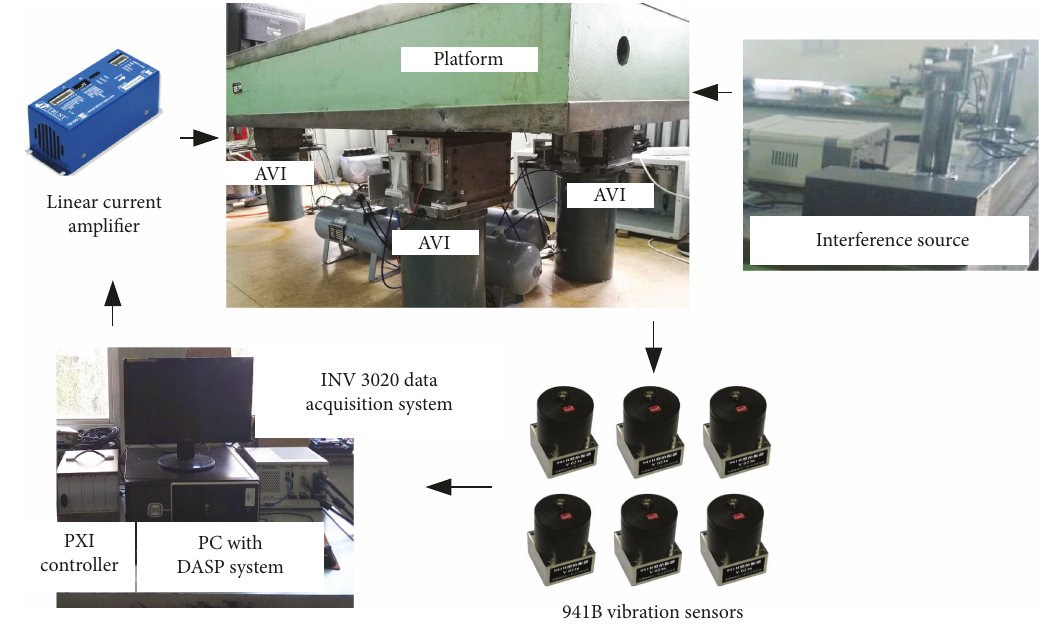
Figure 7: Experiment setup.